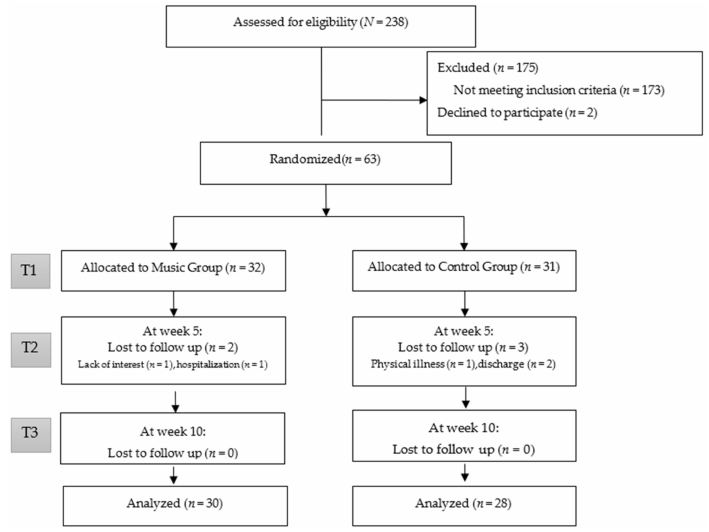
Figure 1. CONSORT diagram for the participants in the